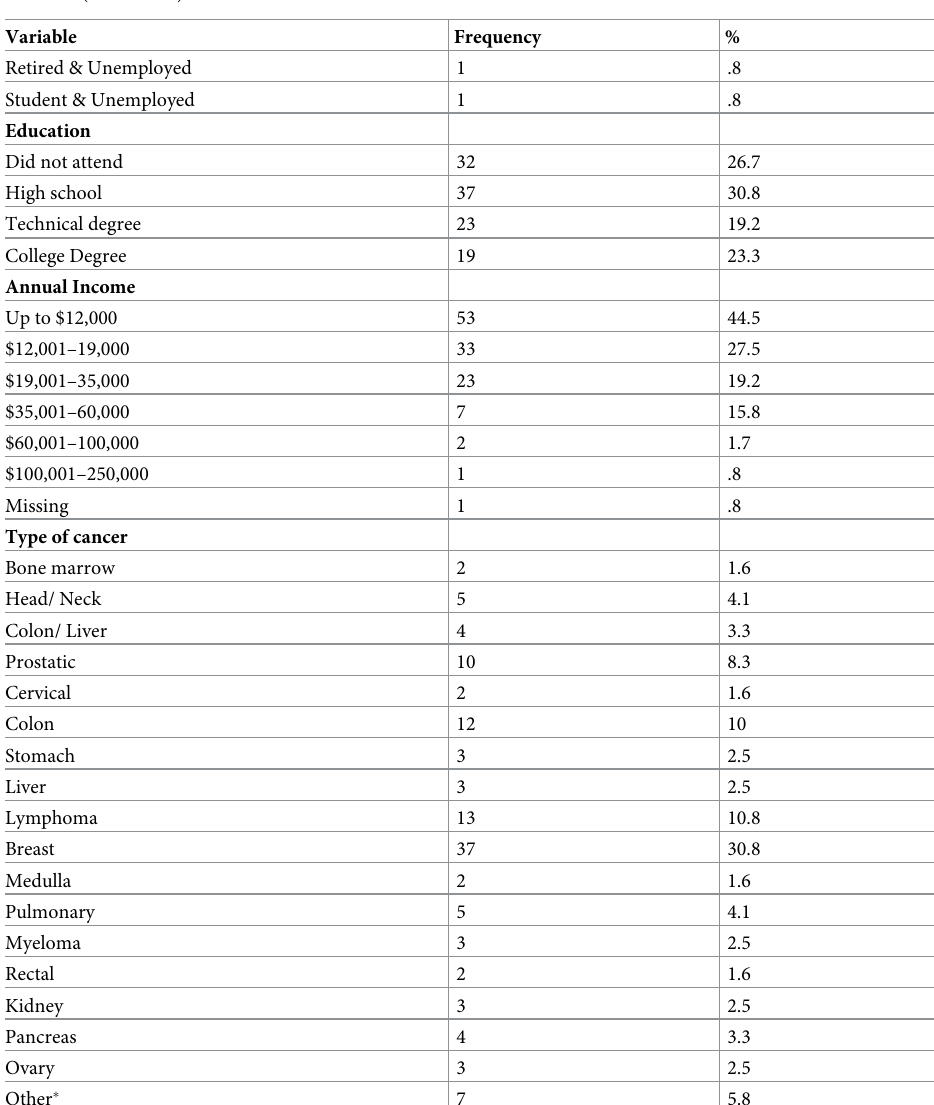
line. The most common type of cancers among participants were: breast cancer: 30.8% (n = 37), lymphoma: 10.8% (n = 13), colon cancer: 10% (n = 12) and prostate: 8.3% (n = 10).